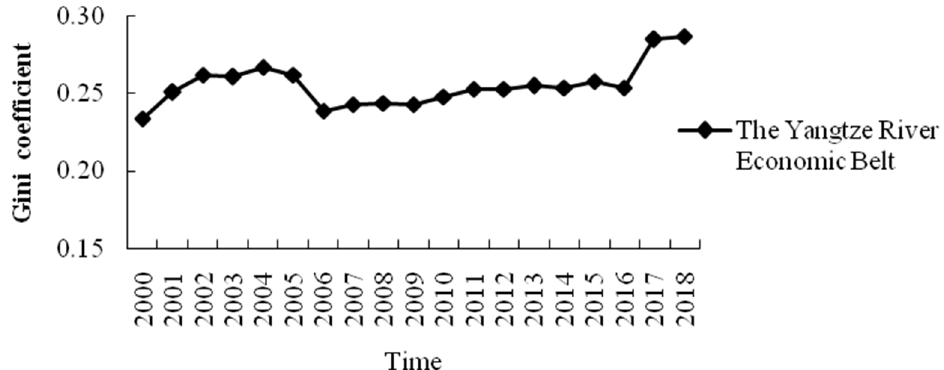
Figure 7. The Gini coefficient of the net carbon sequestration level of food crops in the 11 provinces (cities) of the YREB.